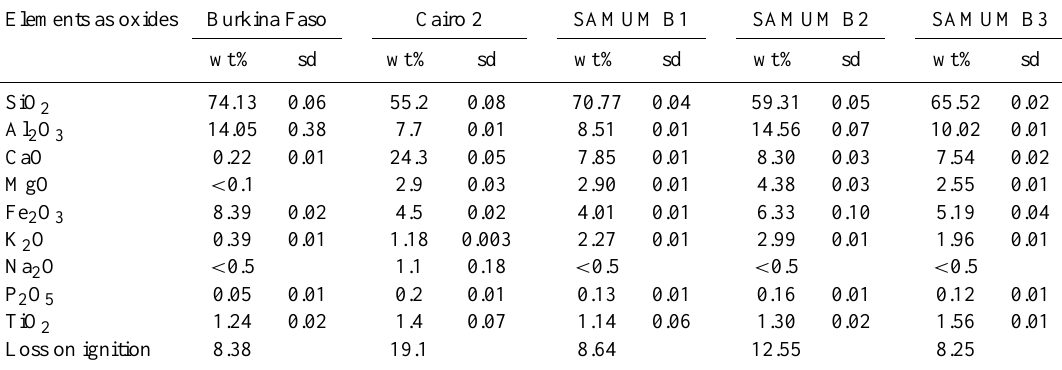
Loss on ignition